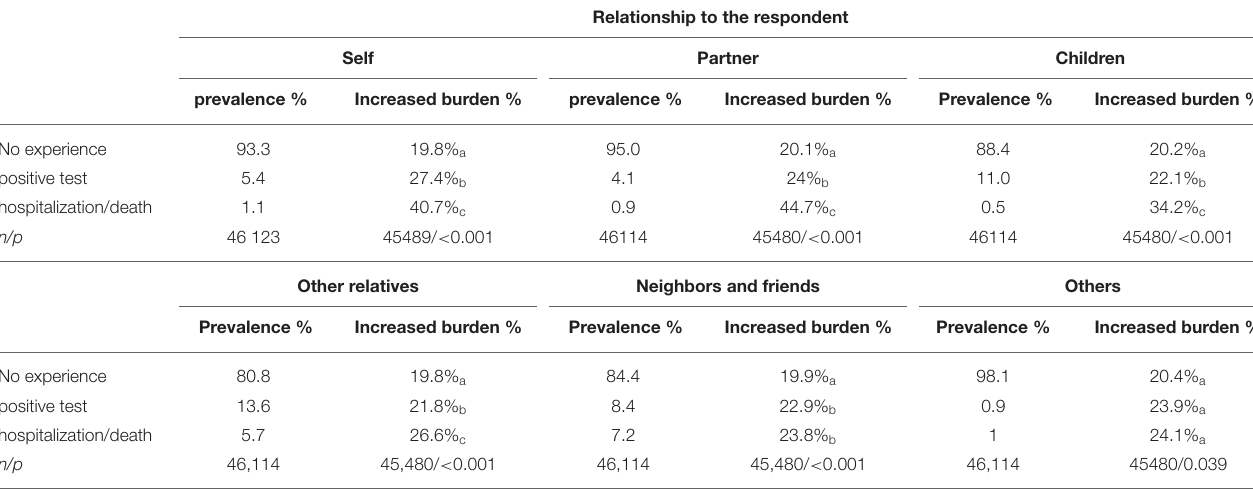
TABLE 3 | Descriptive and bivariate results of severity of COVID-19 experience and increased psychological burden by relationship to affected